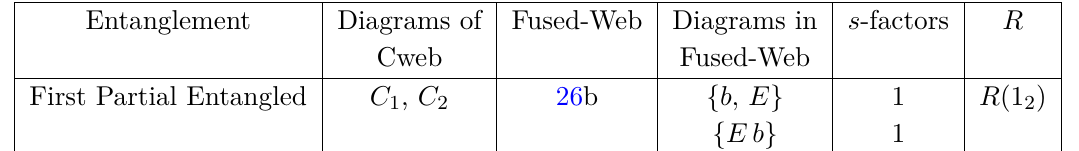
Table 14. Fused-Webs and their mixing matrices for Cweb W (2 , 1)